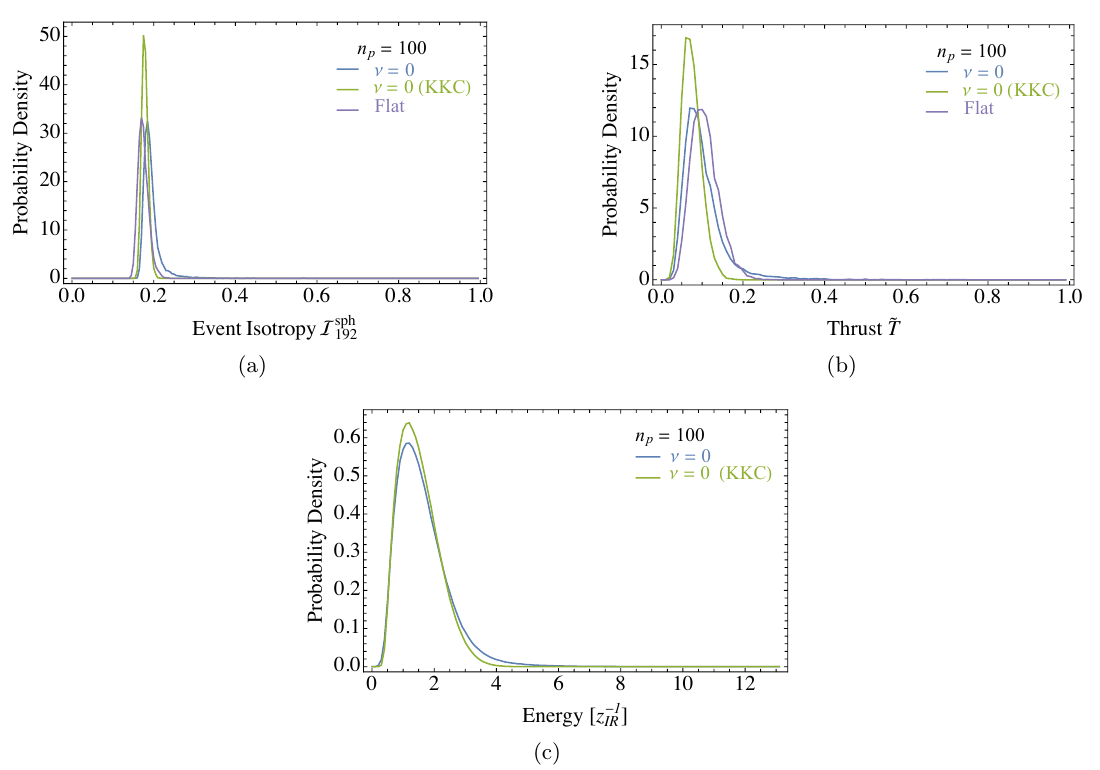
Figure 3 . The (a) event isotropy, (b) thrust, and (c) energy spectra of the final state for cascades generated with ν = 0 with and without KK-number conservation, and the flat case. The multiplicity is not shown as both the KK-number conserving ν = 0 and the flat case distributions are delta functions at 200 particles. The energy spectrum of the flat case is not plotted as it is a delta function at p / 2 ; the other two spectra peak at approximately half the mass of the